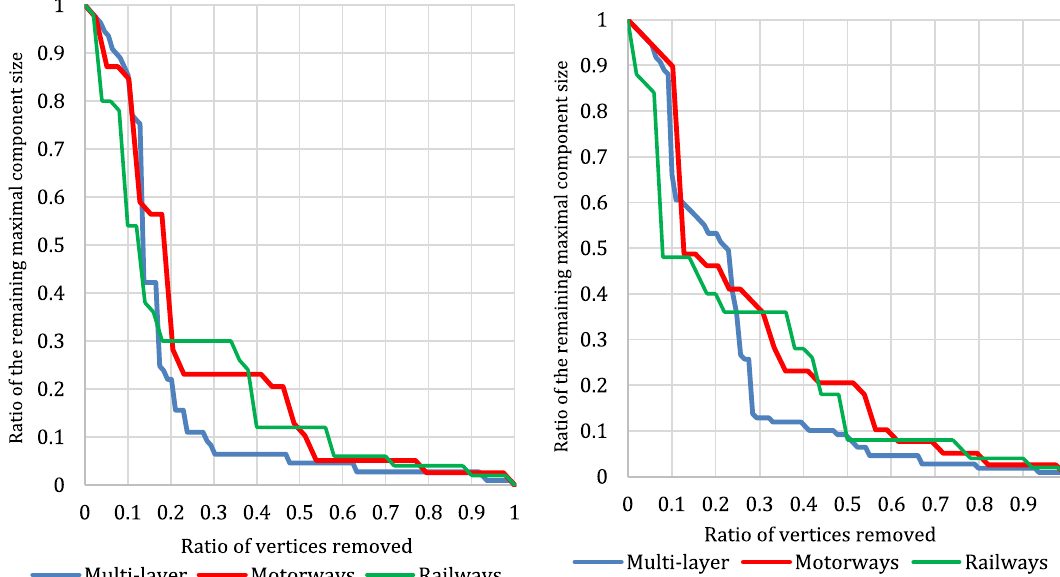
Fig. 8 “Targeted” attack to vertices. Comparison between motorway network, railway network, and multi-layer network with interchange nodes. Notes : Nodes are removed by Degree Centrality (left-hand panel) and by betweenness centrality (right-hand